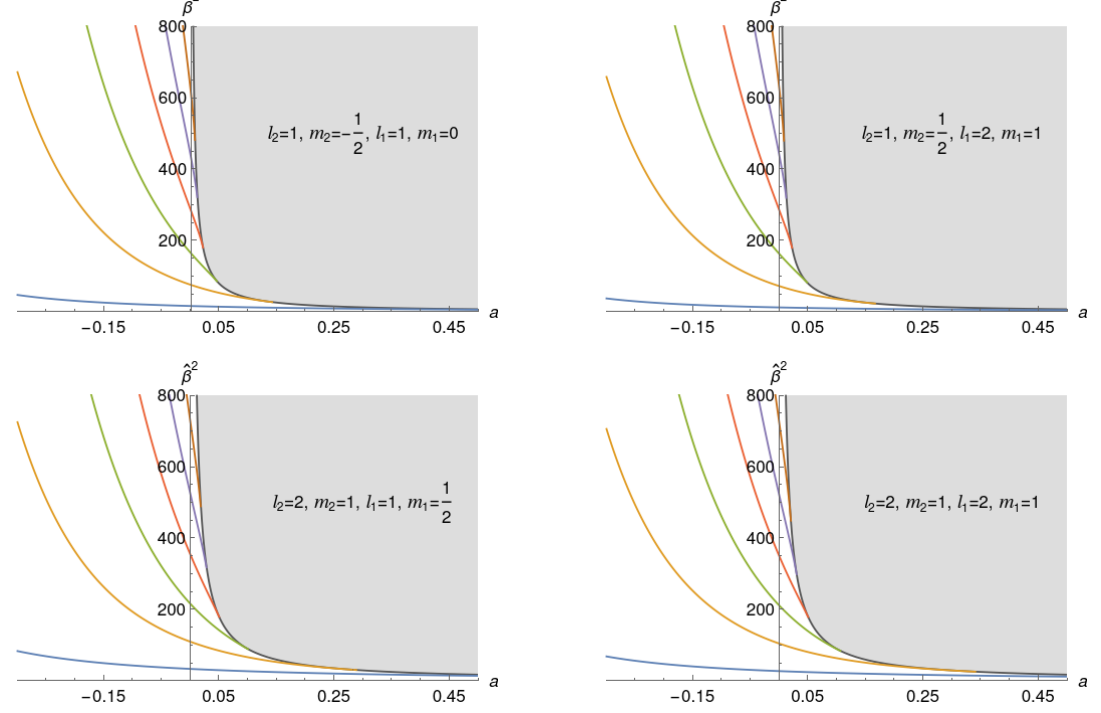
ˆ β 2 of equation (5.49) with = 0 , m R , ‘ and m R (as labelled). Parameter a 1 6 2 1 2